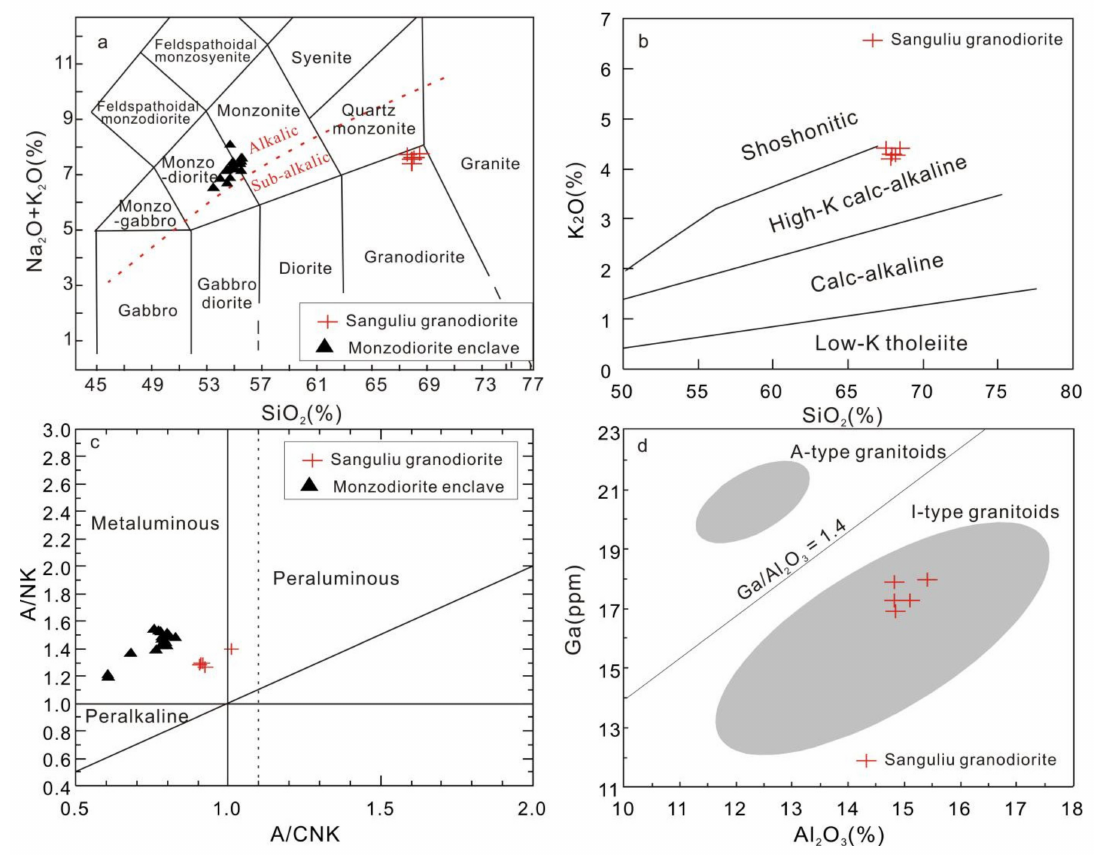
Figure 8. TAS ( a ), SiO 2 versus K 2 O ( b ), A/CNK versus A/NK ( c ), and Al 2 O 3 versus Ga ( d ) diagrams of the Sanguliu granodiorite and its